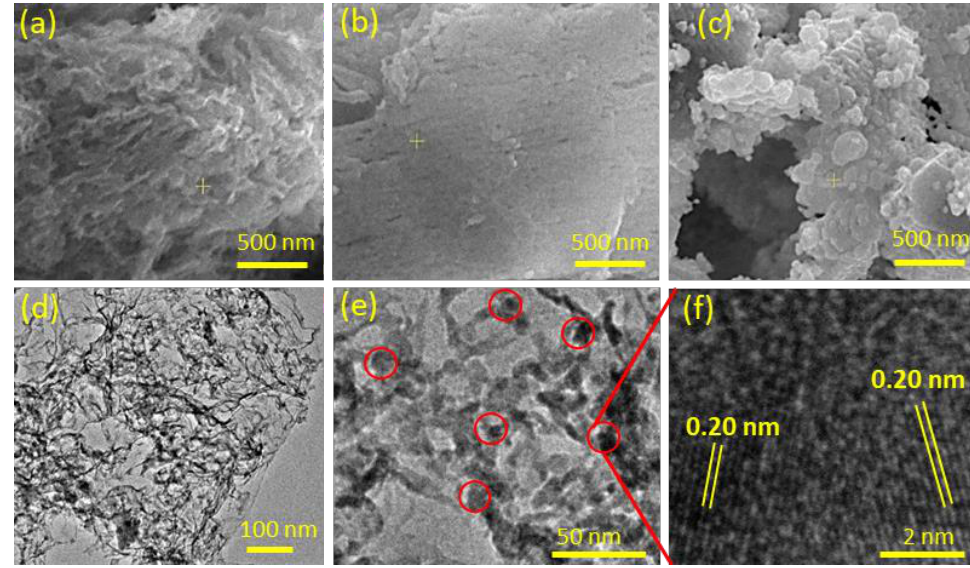
Figure 4. SEM of ( a ) Cu-NP/NC-600, ( b ) Cu-NP/NC-700, ( c ) Cu-NP/NC-700, ( d , e ) TEM of Cu- NP/NC-700 and ( f ) HRTEM of Cu-NP/NC-700.